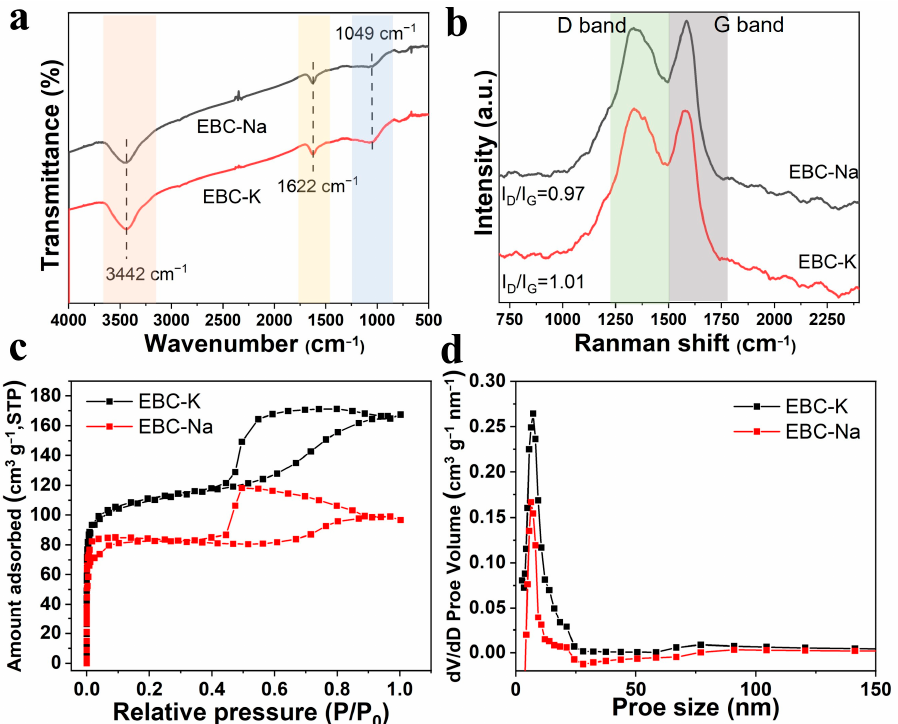
Figure 2. ( a ) FTIR and the ( b ) Raman curves of the EBC ‐ Na and EBC ‐ K. ( c ) N 2 adsorption/desorption isotherms and ( d ) pore size distribution of EBC ‐ Na and EBC ‐ K.